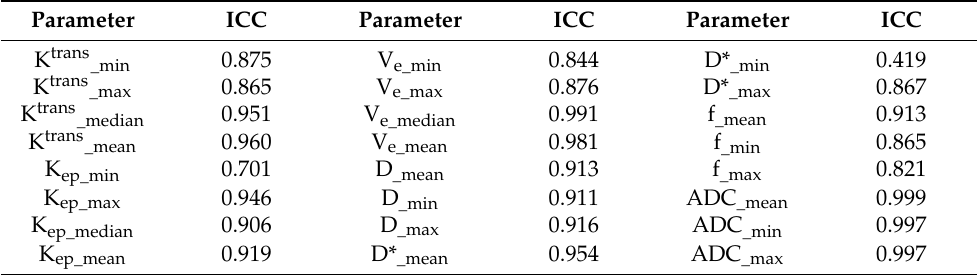
Table 2. Consistency test results for each